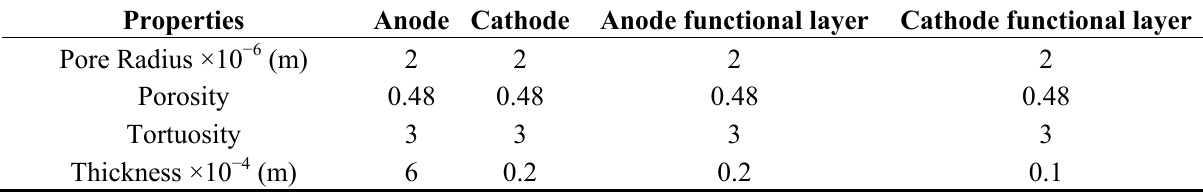
Table 1. Physical properties of the electrodes materials.